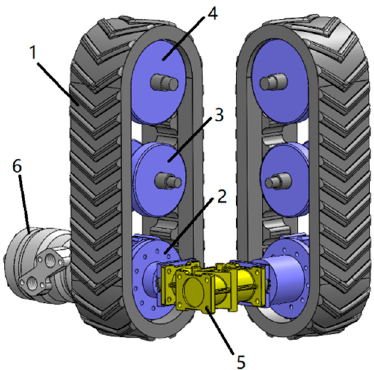
Figure 6. Traveling mechanism: 1—rubber track; 2—main wheel; 3—support wheel; 4—tensioning wheel; 5—1:1 bevel gear right-angle commutator; 6—hydraulic motor.